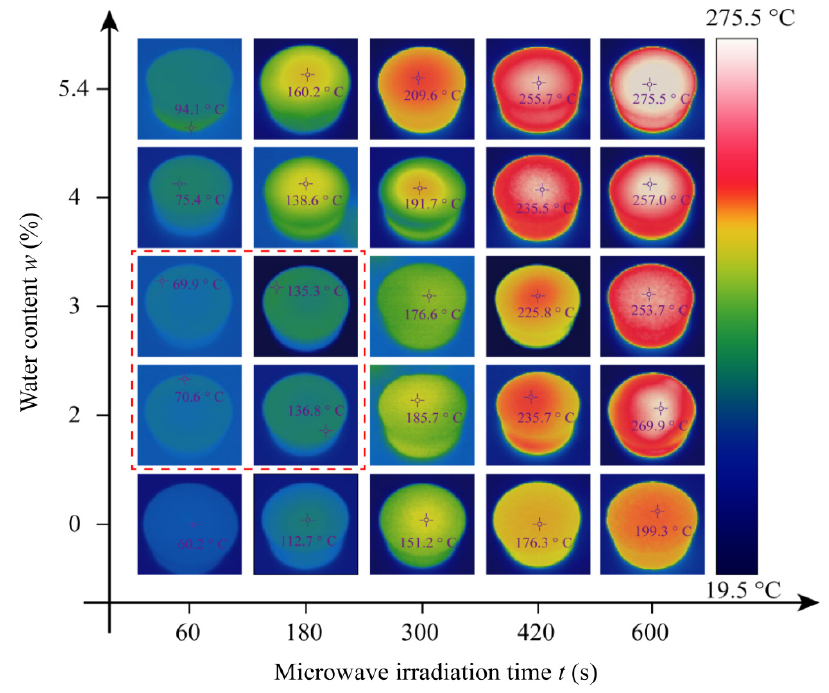
Figure 8. Surface temperature of the sandstone samples for different duration of microwave radia-